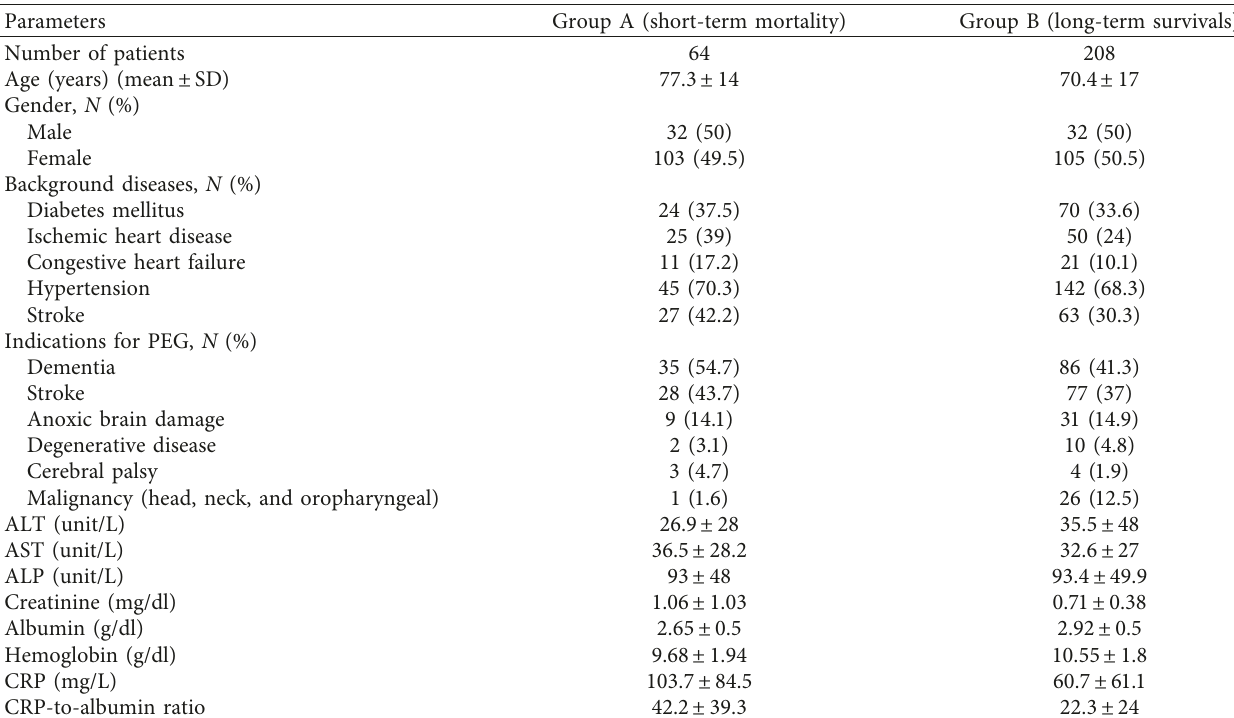
Table 1: Demographics and laboratory characteristics of study cohort.